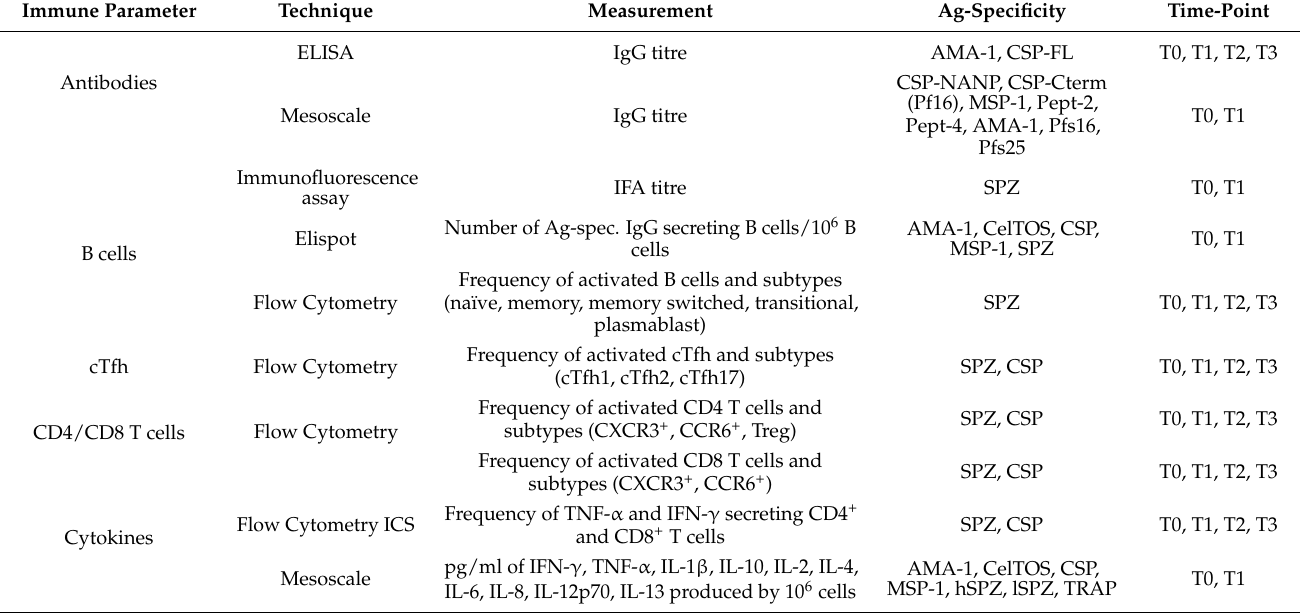
Table 1. Summary of all immune measures collected to establish immune signatures correlating with sterile